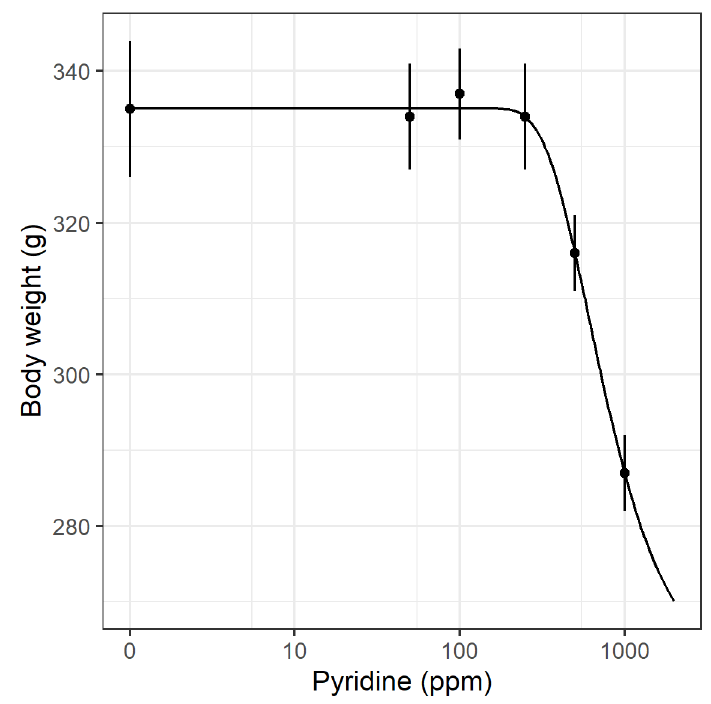
Figure 5: ggplot of a drc object